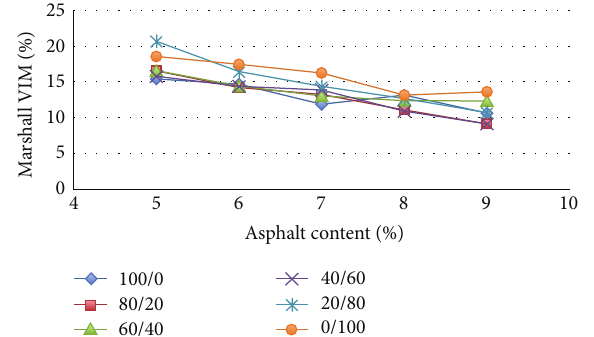
Figure 6: Marshall VIM of specimens (%) at each asphalt content and coarse aggregate proportion.